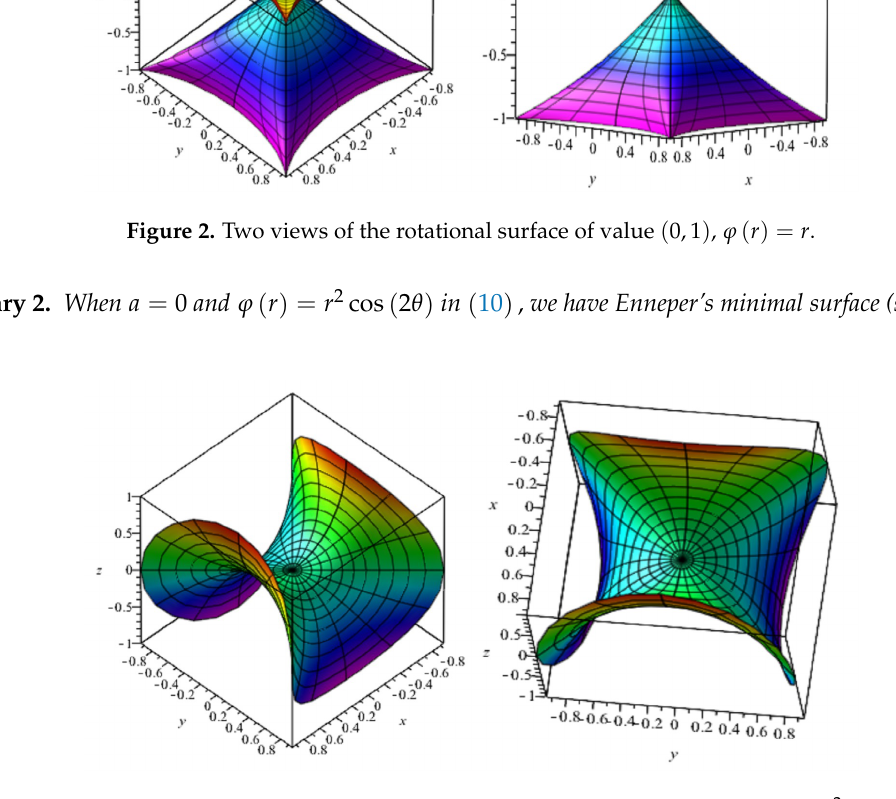
Figure 3. Two views of the Enneper minimal surface of value ( 0,1 ) , a = 0, ϕ ( r ) = r 2 cos ( 2 θ )